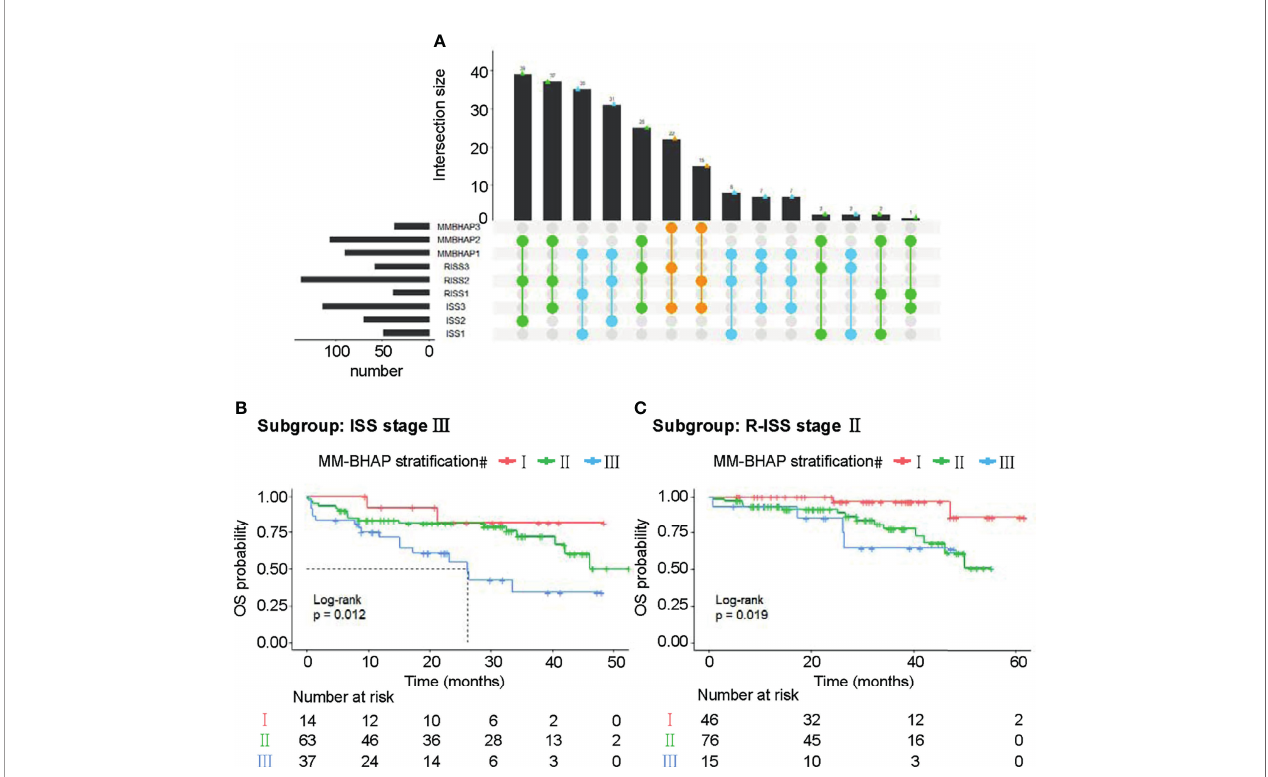
FIGURE 5 | Subgroup analyses about the three risk strati fi cations in the development cohort. (A) The distribution and co-occurrence of the patients respectively classi fi ed by the MM-BHAP strati fi cation, R-ISS stage, and ISS stage in the development cohort were displayed. Dots with connected lines represented that the patients coexisted in corresponding different subgroups and the vertical bar graphs re fl ected the number of these patients. Also, the blue, green, and orange dots respectively represented the co-occurrence of the patients classi fi ed by stage I, stage II, and stage II of the MM-BHAP strati fi cation with other subgroups. (B) OS curves in the subgroup with ISS stage III strati fi ed by the MM-BHAP model. (C) OS curves in the subgroup with R-ISS stage II strati fi ed by the MM-BHAP